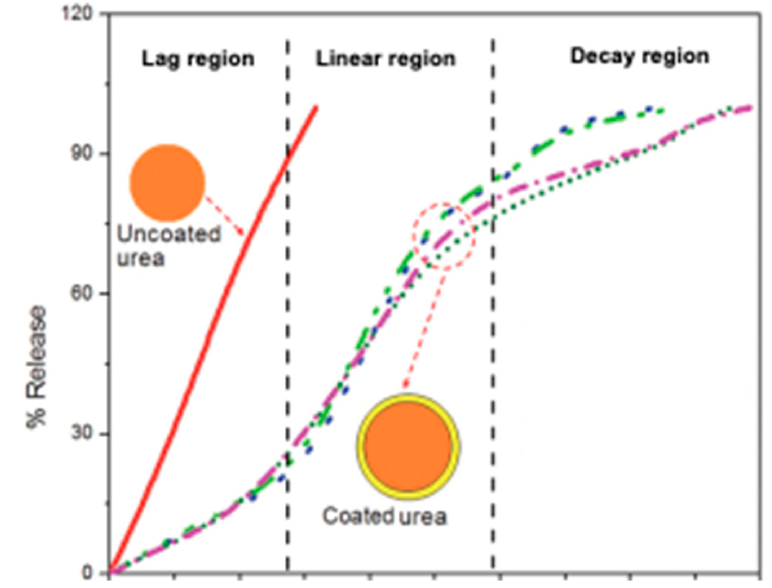
Figure 6. Nitrogen release pa tt ern of uncoated urea and coated urea [78].